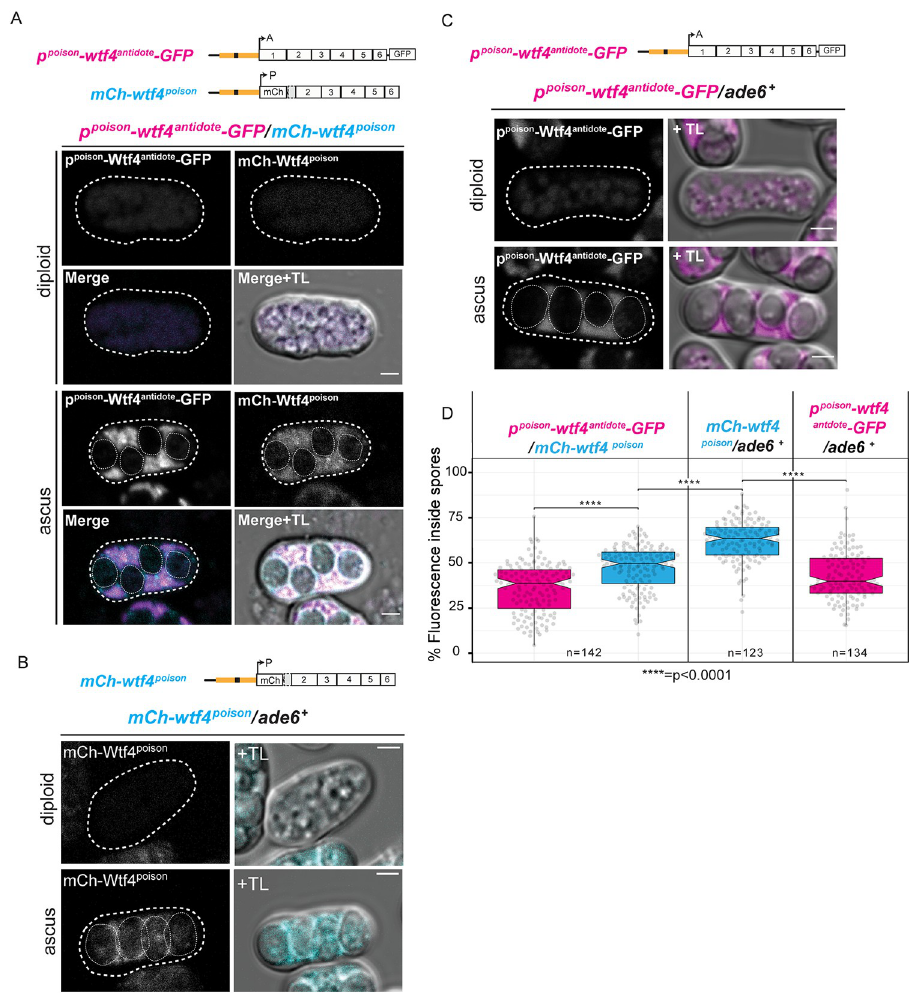
Fig 4. Wtf4 antidote is excluded from developing spores more than the Wtf4 poison . ( A ) Image of a p poison - wtf4 antidote - GFP/ mCherry-wtf4 poison diploid and ascus. ( B ) Image of a mCherry-wtf4 poison / ade6+ diploid and ascus. ( C ) Image of p poison -wtf4 antidote -GFP / ade6+ diploid and ascus. ( D ) Quantification of the percentage of the total fluorescence intensity found inside of spores of mature asci produced by p poison - wtf4 antidote -GFP/ mCherry-wtf4 poison (left, n = 142), mCherry-wtf4 poison /ade6 + diploids (center, n = 123) and p poison -wtf4 antidote -GFP/ade6 + diploids (right, n = 134). p poison - Wtf4 antidote -GFP fluorescence data is depicted in magenta while mCherry-Wtf4 poison is depicted in cyan. Error bars depict the 95% confidence interval. p poison -Wtf4 antidote -GFP is shown in magenta and mCherry-Wtf4 poison is shown in cyan in merged images. TL = transmitted light. All scale bars represent 2 μ m. All images were acquired after 1 day on sporulation media. Images were taken at the same settings and are shown at the same brightness and contrast for accurate comparison. Our genetic results indicate that the Wtf4 poison expressed from the p antidote promoter is defective at killing spores that do not inherit the allele encoding the Wtf4 poison . This is surpris- ing given the high sensitivity of mitotic S . pombe cells to even low levels of Wtf4 poison we observed in previous work [52] and in this study (e.g., S9 Fig Diploid 24). We hypothesized that the Wtf4 antidote is better at preventing Wtf4 poison from entering spores when the proteins were co-expressed from the p antidote promoter than when the Wtf4 poison is expressed from its endogenous promoter. To test this possibility, we compared the amount of Wtf4 poison signal in spores produced by diploids heterozygous for both p antidote -wtf4 poison -GFP allele (at ade6 ) and wtf4 antidote -mCherry (at ura4 ) to similar control diploids in which wtf4 poison -GFP was expressed